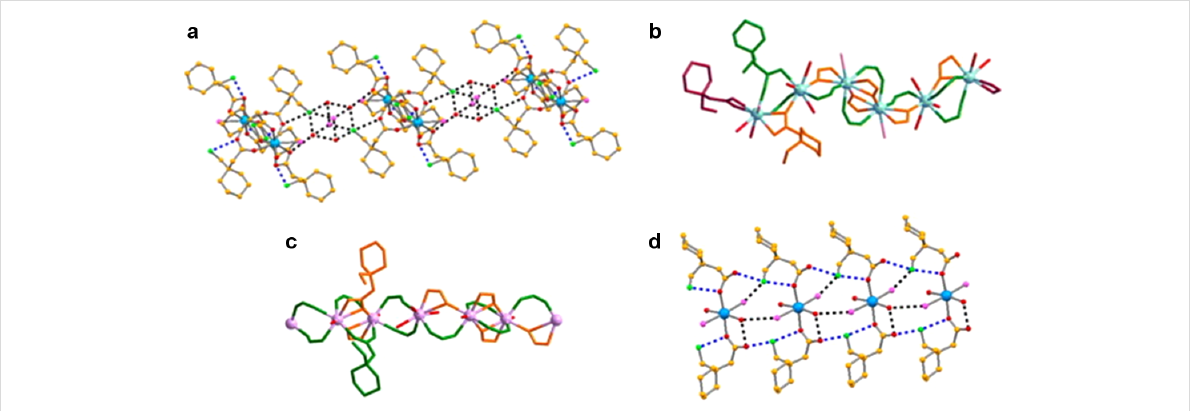
Figure 1: a) Detailed supramolecular packing of a gabapentin–Er network; b) view along the b -axis of the supramolecular packing of a gabapentin–Ce network; c) view of a GBP–Y network showing an infinite 1D chain; d) simplified packing of a gabapentin–Mn network. H atoms were omitted for clarity. Reprinted with permission from [49], copyright 2017 Elsevier.